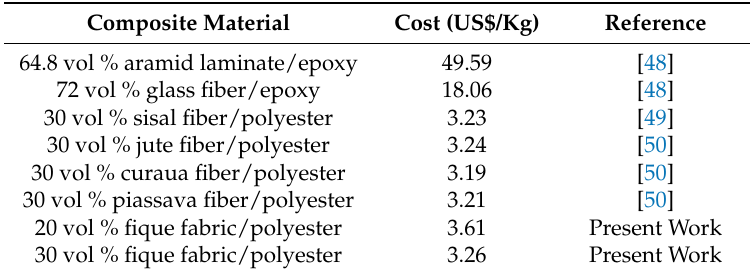
Table 2. Cost model for different fabric composites.